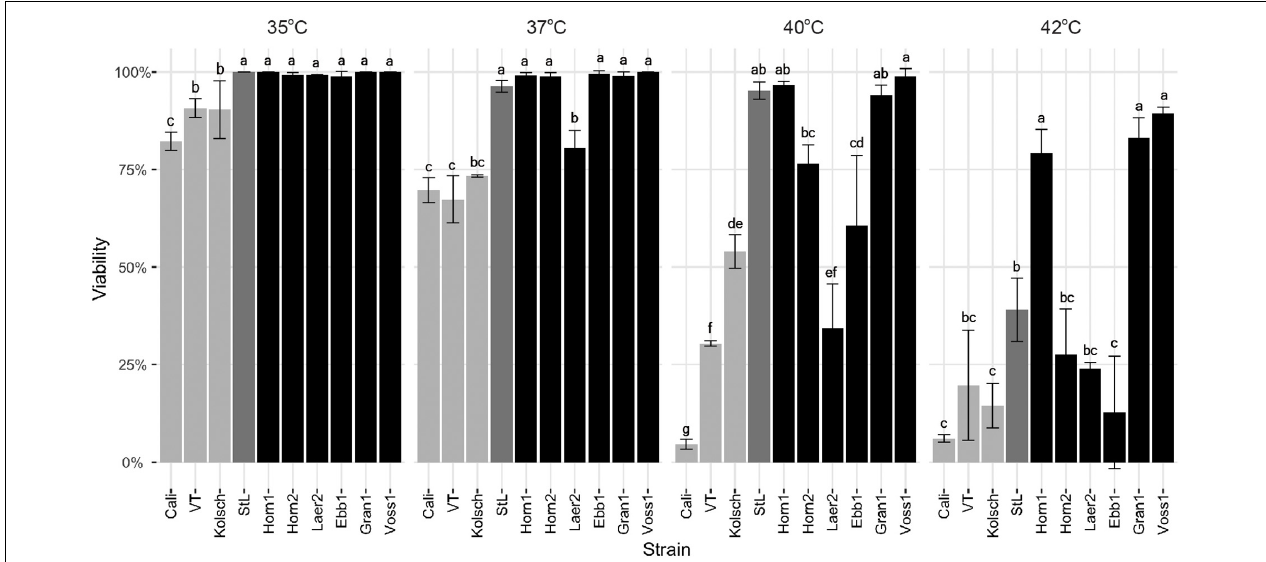
FIGURE 8 | Cell viability following heat treatment. Single colonies of the indicated four commercial ale yeast controls and six Norwegian kveik strains were inoculated into YPD and cultured for 24 h with shaking at 170 rpm at 35, 37, 40, and 42 ◦ C. Cell viability was ascertained via staining with Trypan Blue. Error bars represent SD, n = 3. Data was subjected to one-way ANOVA followed by Tukey’s HSD analysis of the mean viability between strains for each temperature (Viability ∼ Strain). Mean values assigned with a common letter are not significantly different by the HSD-test at the 5% level of significance within the same temperature.